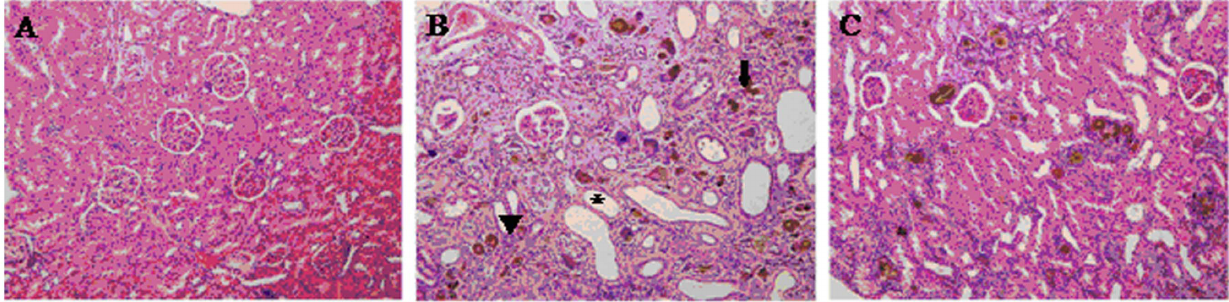
Figure 4. Histologic findings by HE-staining of transverse kidney sections. (A) normal control rats, (B) adenine-induced CKD rats and (C) FLP-treated group with CKD rats. Large dilated tubule (asterisk); lymphocytic infiltrate (arrowheads); 2,8-dihydroxyadenine crystal (arrows). There was formation of foreign body granuloma in the renal tubules and interstitium and a marked fibrosis leading, in some extreme cases, to a contracted kidney. These results demonstrate that the rat model exhibited the typical pathological features associated with CKD.